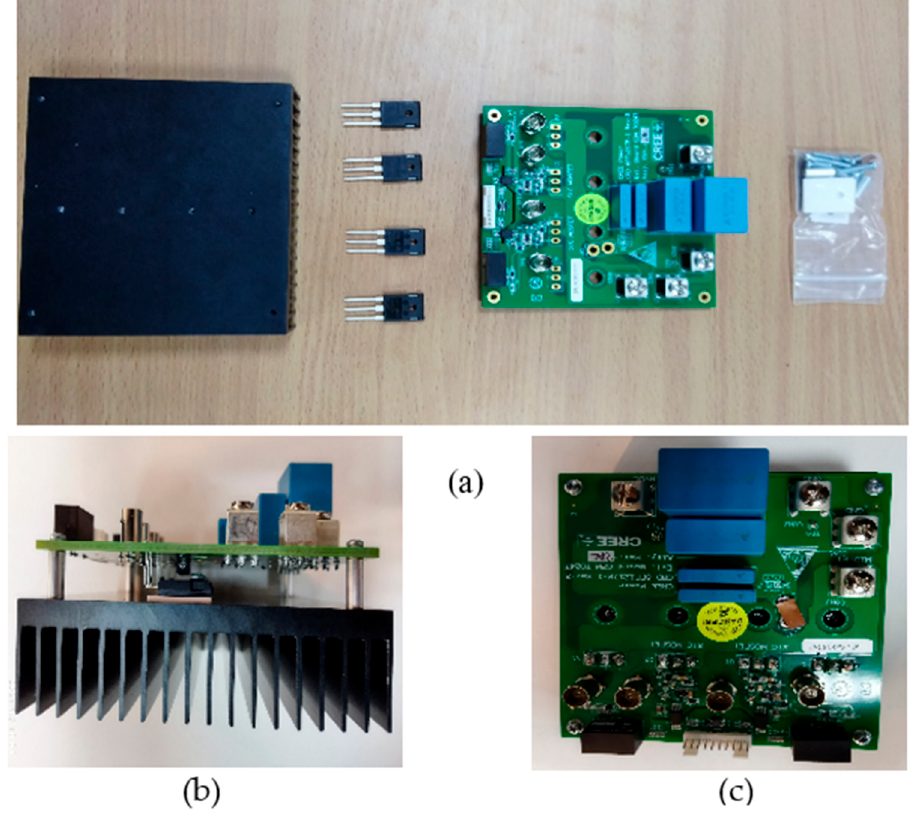
Figure 12. ( a ): Package content of the SiC MOSFET evaluation kit, ( b ): side view of the mounted board, ( c ): top view of the mounted board.